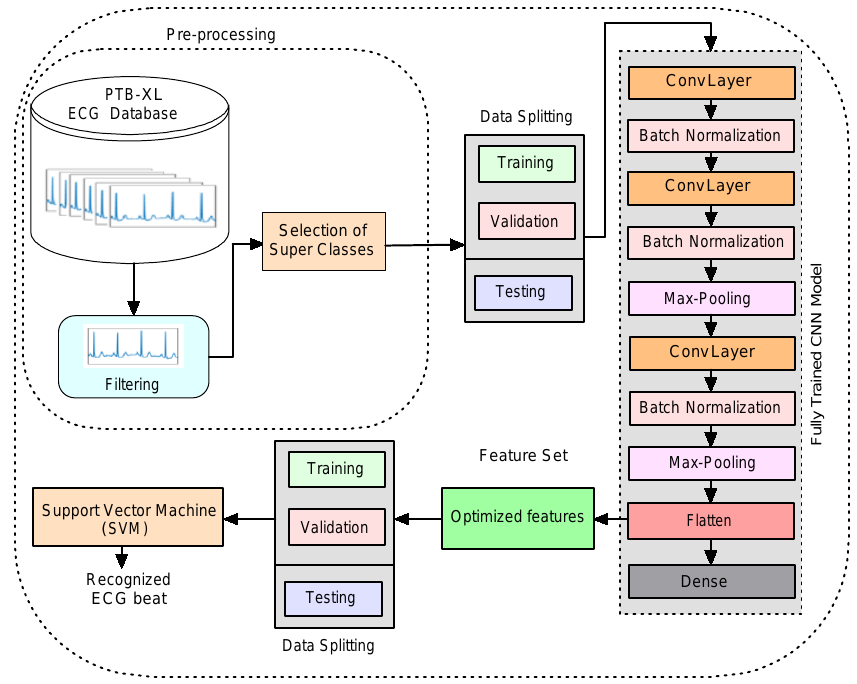
Figure 1. General diagram of the proposed